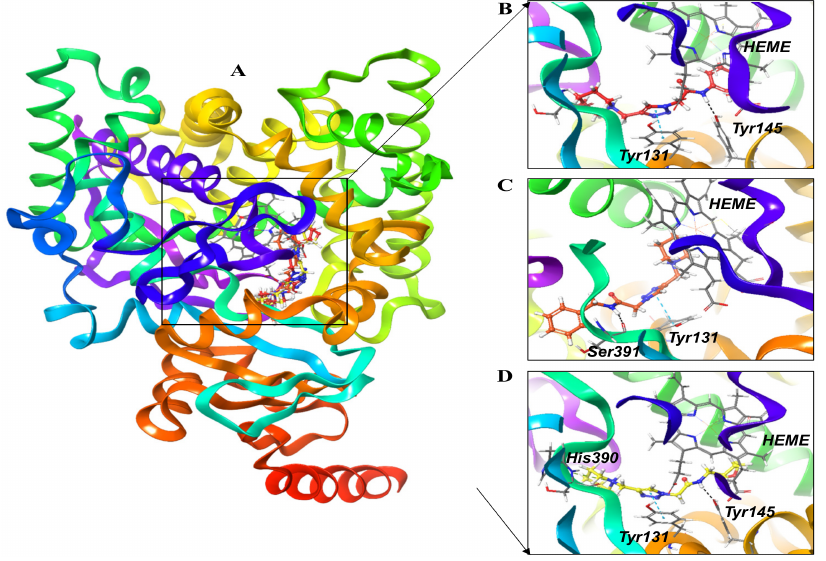
Figure 1. ( A ) Structural representation of LDM enzyme with HEM ion and three superimposed studied inhibitors in the active pocket. Molecular interactions of ( B ) pta1 (red color), ( C ) pta2 (orange color), and ( D ) pta3 (yellow color) with the active site residues of LDM enzyme.